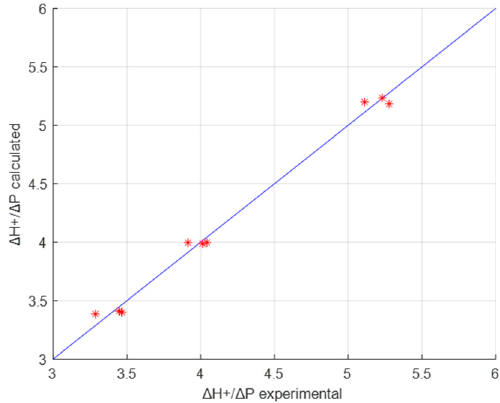
Figure 8. Comparison of the experimental ( * ) and calculated values of y = Δ H + / Δ P for Toolse 2 sample according to model 5.